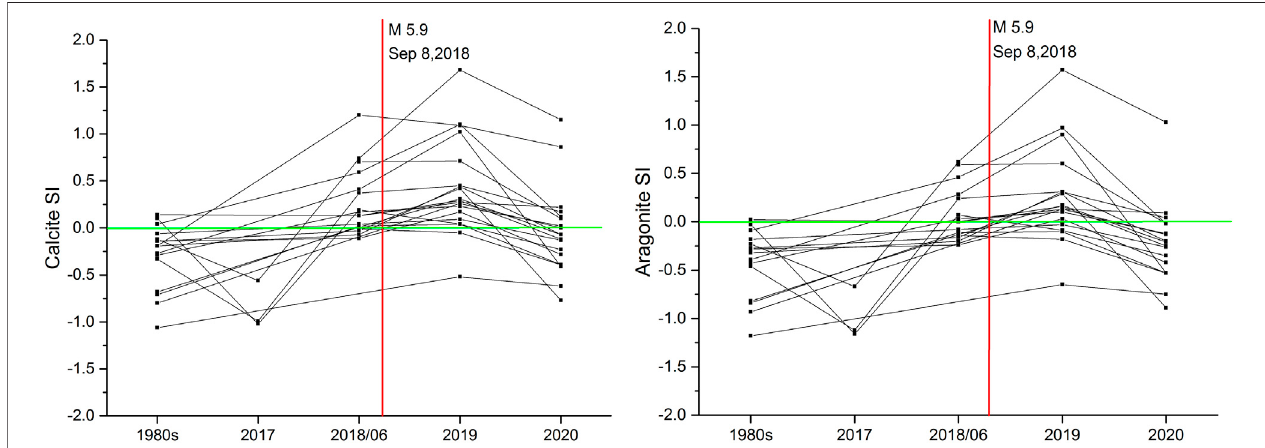
FIGURE 9 | Variations in the SIs of calcite and aragonite in the hot springs from the 1980s to 2020.